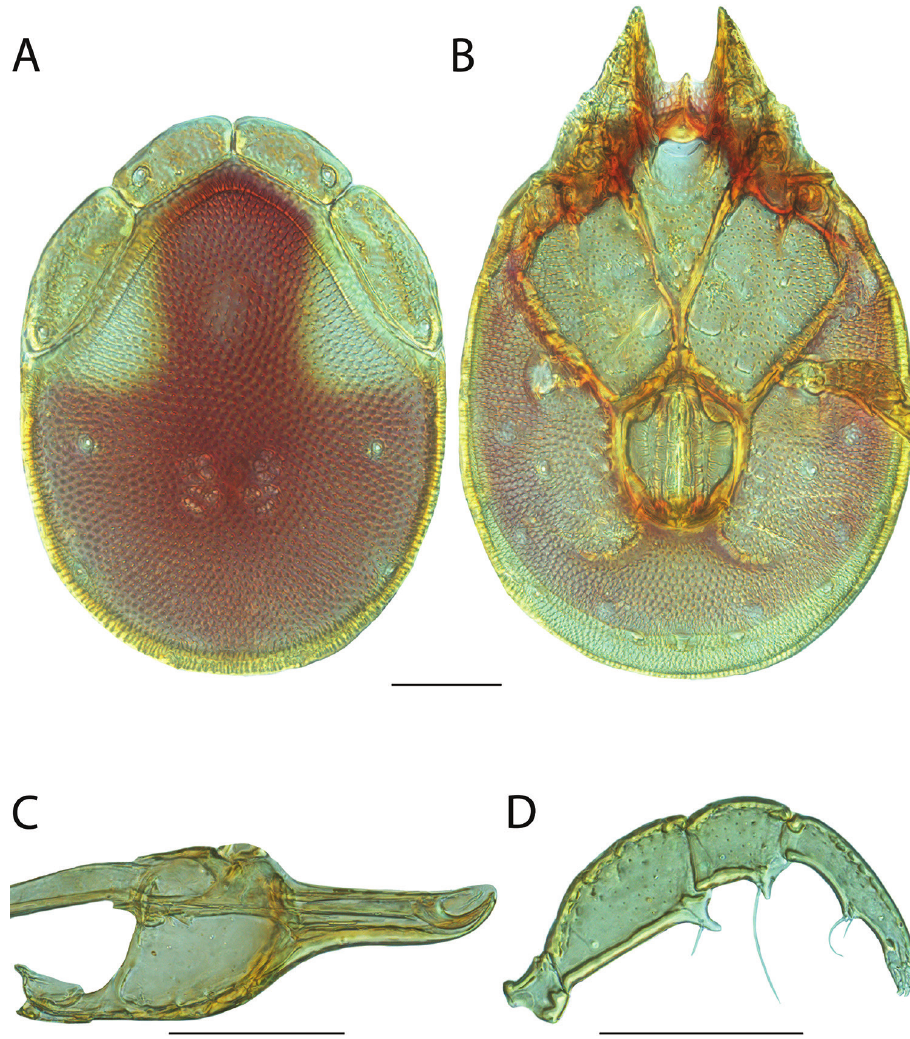
Figure 49. Torrenticola danielleae sp. n. male: A dorsal plates B venter (legs removed) C subcapitulum D pedipalp (setae not accurately depicted). Scale = 100 µm.